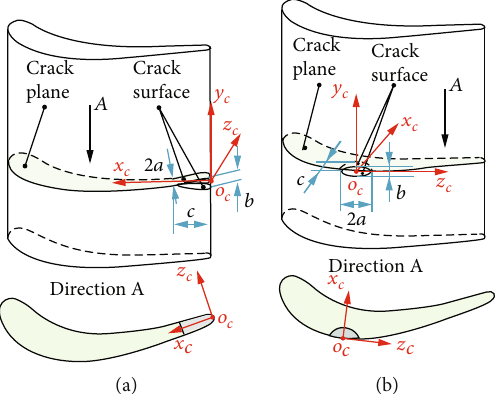
Figure 7: The schematic of crack size. (a) The through-thickness crack. (b) The surface